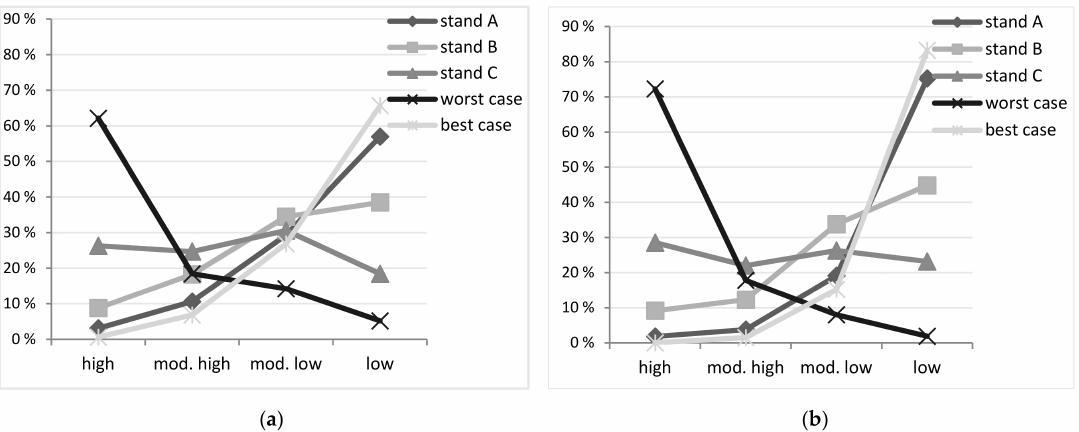
Figure 7. ( a ) Probabilities ( y -axis) for bark beetle predisposition categories ( x -axis) over five stand types; ( b ) Probabilities ( y -axis) for storm damage predisposition categories ( x -axis) over five stand types.